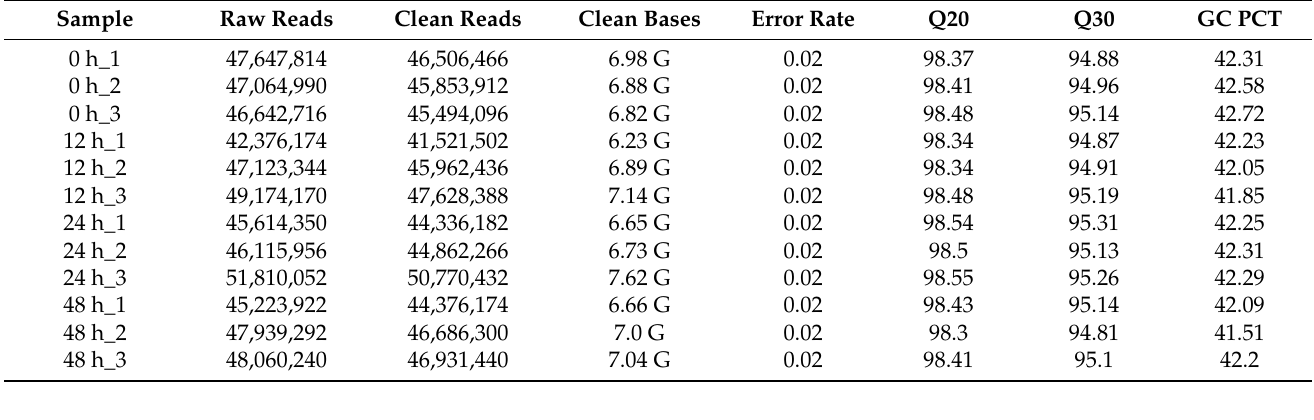
Table 1. RNA-sequencing quality.